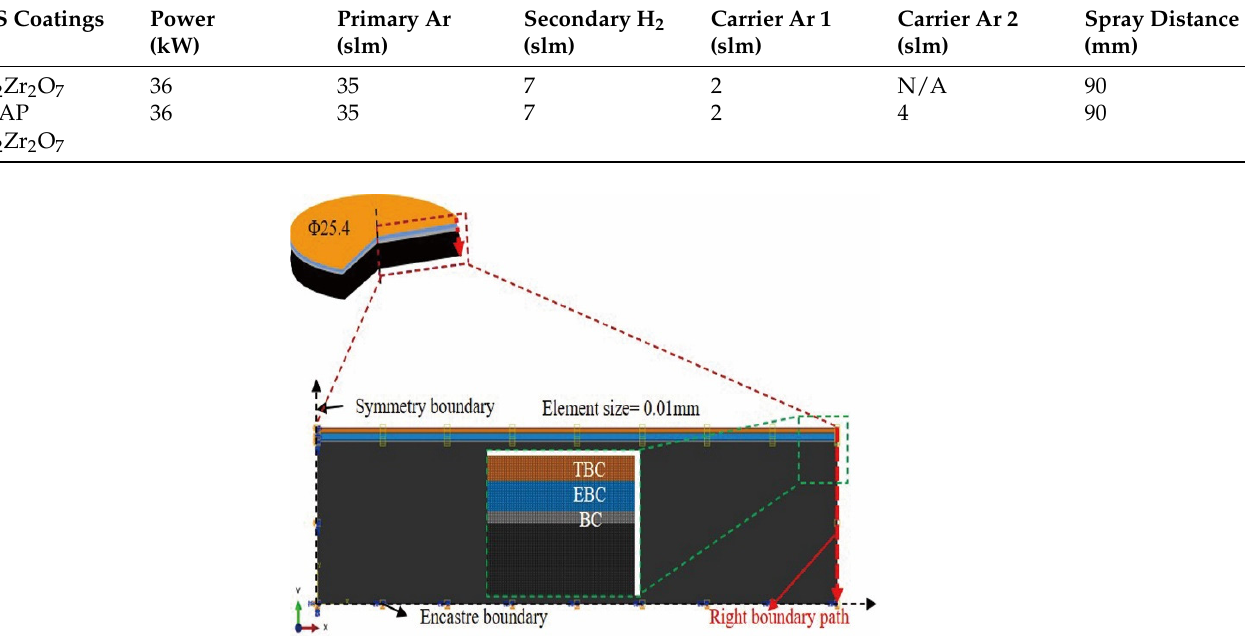
Table 1. Operating parameters used for air plasma spray.